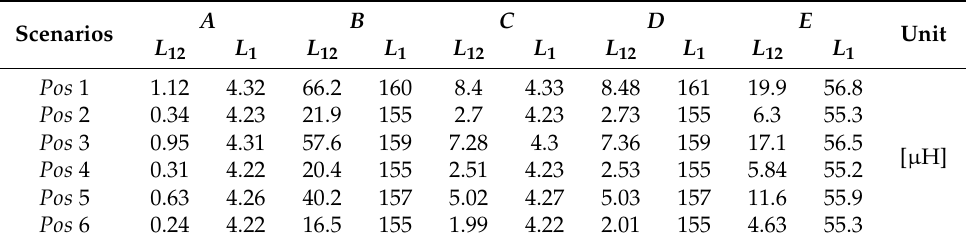
Table 3. FEA simulation results of all Scenarios in each Pos for the 650 mm FLCP.